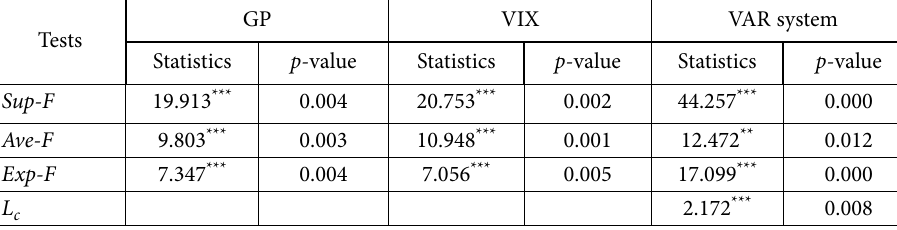
Table 3. The results of parameter stability test